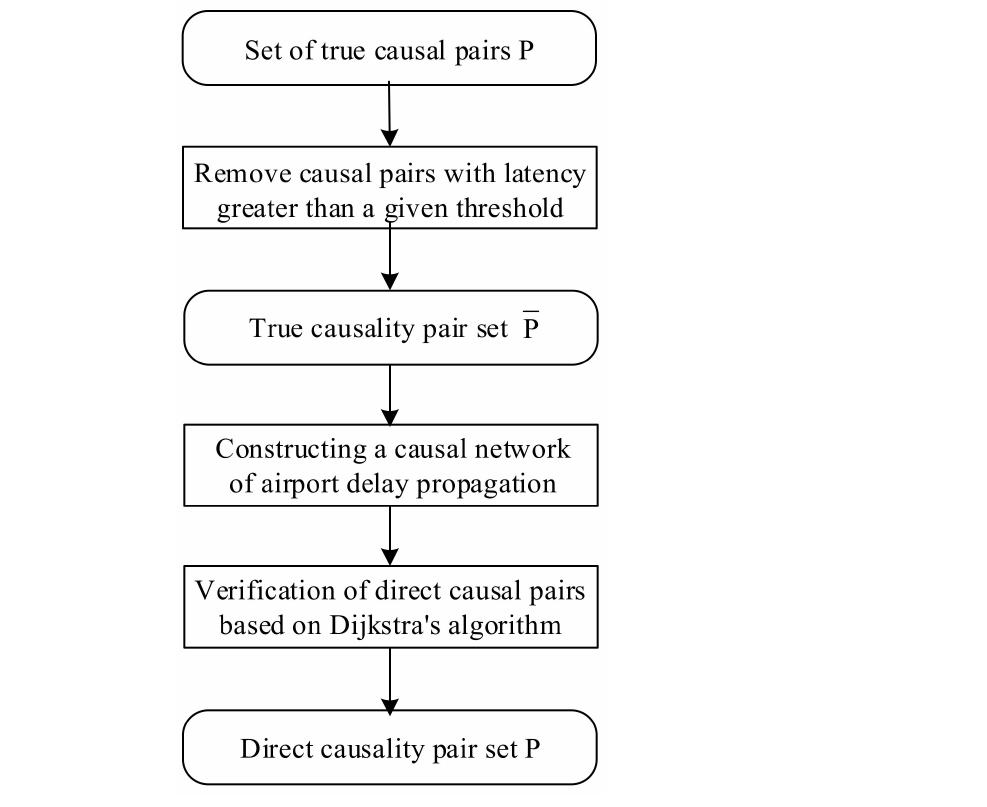
Figure 9. Flow chart of direct causality verification based on propagation delay